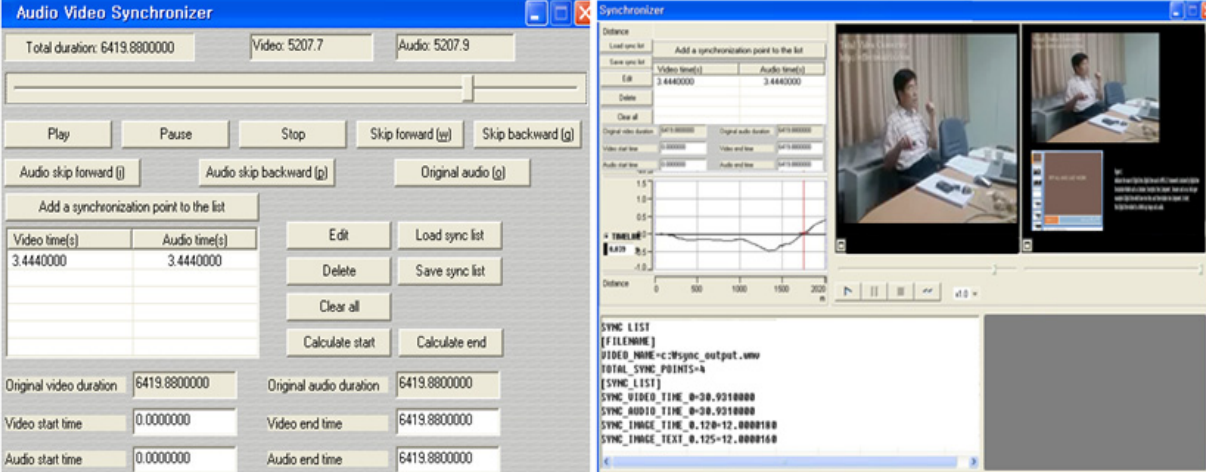
Figure 8. Synchronization of Fusion